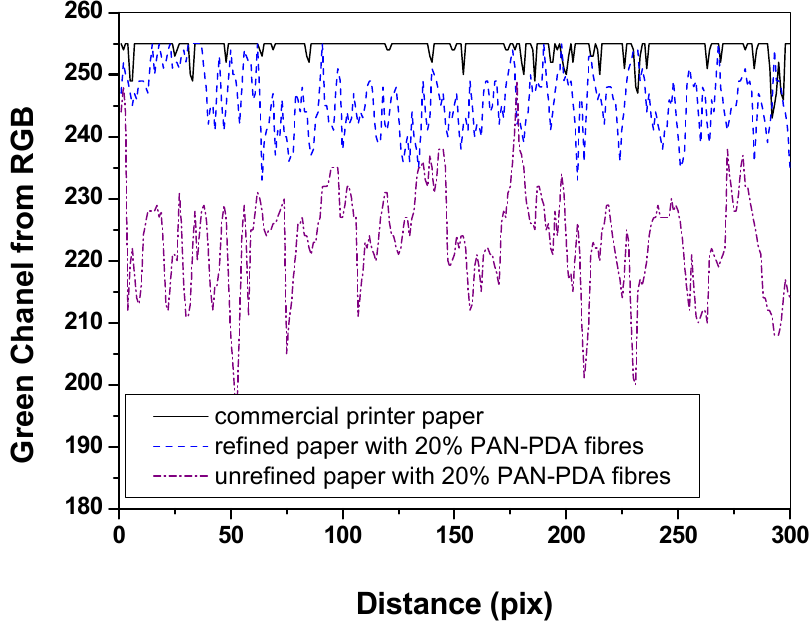
Figure 9. Comparison of surface unevenness of paper samples (commercial paper, unrefined paper with 20% PAN–PDA fibres, and refined paper with 20% PAN–PDA fibres).